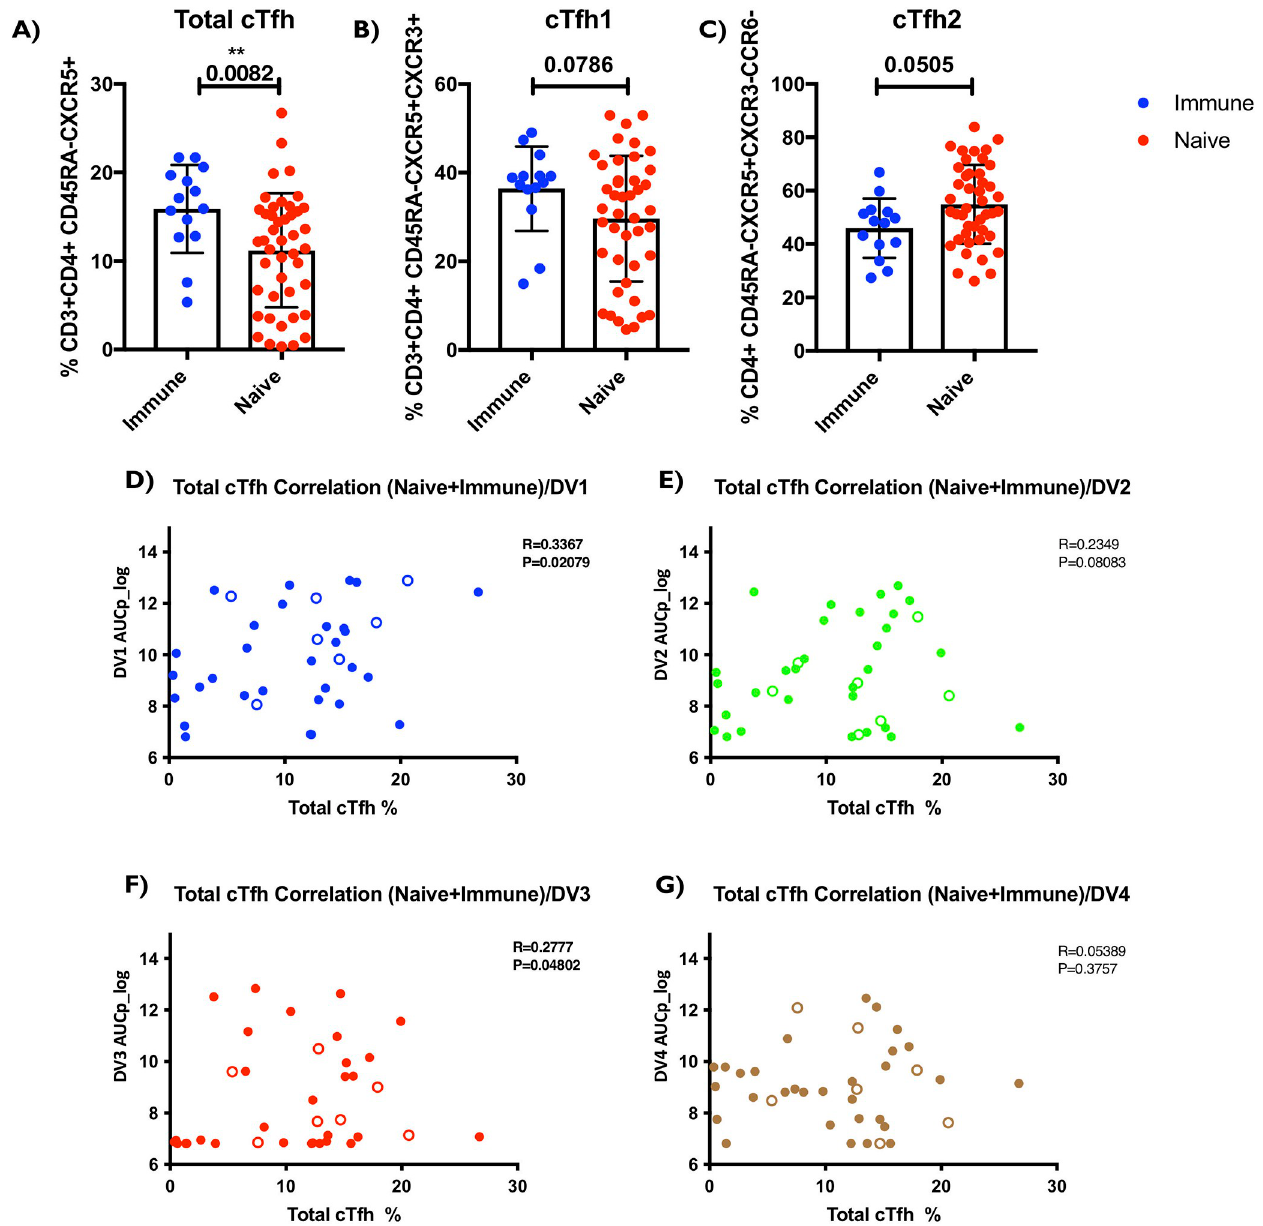
Fig 3. Higher baseline/pre-vaccination frequency of total cTfh in the seropositive (Immune) than seronegative (Na ï ve) group, positively correlate with neutralizing antibody titers AUCp. (A) Y axis is the total cTfh Frequency CD3+ CD4+ CD45RA- CXCR5+. (B) Y axis is the cTfh1 frequency CD3+ CD4+ CD45RA- CXCR5+ CXCR3+ CCR6-. (C) Y axis is the cTfh2 frequency CD3+ CD4+ CD45RA- CXCR5+ CXCR3- CCR6-. (D) Total cTfh frequency (CD3+ CD4+ CD45RA- CXCR5+) correlation with dengue serotype 1 AUCp. (E) Total cTfh frequency (CD3+ CD4+ CD45RA- CXCR5+) correlation with dengue serotype 2 AUCp. (F) Total cTfh frequency (CD3+ CD4+ CD45RA- CXCR5+) correlation with dengue serotype 3 AUCp. (G) Total cTfh frequency (CD3+ CD4+ CD45RA- CXCR5+) correlation with dengue serotype 4 AUCp. Pre-vaccination/baseline subjects PBMCs and optimized T cell panel for ex-vivo staining was utilized. 1 million cells per panel were stained. (Na ï ve n = 44, Immune n = 14.) Unpaired non-parametric Mann Whitney test, 95% confidence was calculated for (A-C) . Non-parametric Spearman Correlation (R = rho) with 95% confidence interval was calculated between Total cTfh frequencies and Area Under the Curve (AUCp) for DV serotypes 1–4. (n = 37 for (D-G) ). Before vaccination, seropositive subjects with existing antibodies to any of the four Dengue virus serotypes due to prior infection were referred to as (“Immune, hollow points”) or seronegative subjects with no existing antibodies to any of the four Dengue virus serotypes were referred to as (“Na ï ve, solid points”). Nominal p-values p < 0.05 were considered statistically significant. � p < 0.05, �� p < 0.01 and ��� p < 0.001. ���� p < 0.0001.